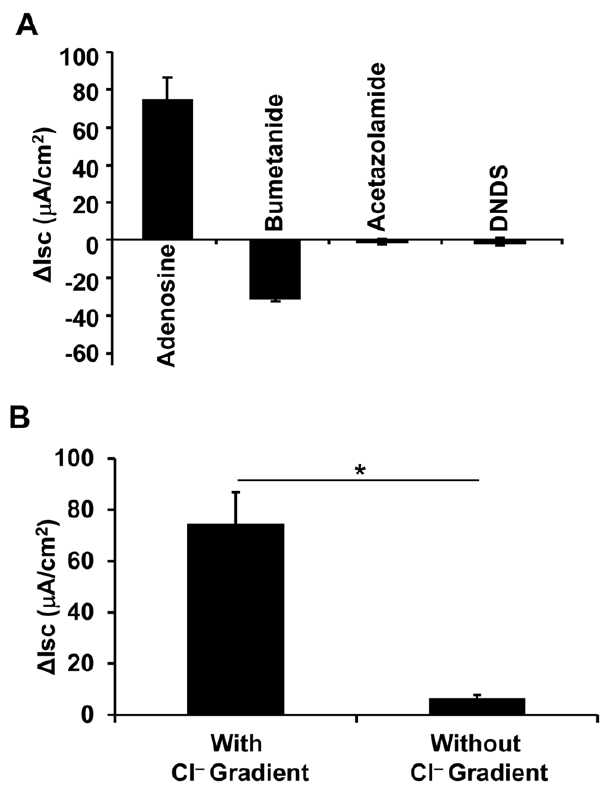
Figure 2. Adenosine-stimulated short circuit current is chloride conductance. A ) I SC of Calu-3 epithelia was measured by using the asymmetric chloride buffers. After stimulated with 100 m M of apical adenosine, the cells gave rise to I SC of , 75 m A/cm 2 . The I SC was blocked by , 58% by basolateral addition of bumetanide (100 m M), but not by acetazolamide (20 m M) or DNDS (100 m M). B ) I SC of Calu-3 epithelia was measured with either asymmetric chloride buffers or symmetric chloride buffers. The adenosine-stimulated I SC with no chloride-gradient buffers was , 92% lower than that with chloride-gradient buffers. Significance of the difference was determined by Student’s t-test ( p , 0.01, n=5).